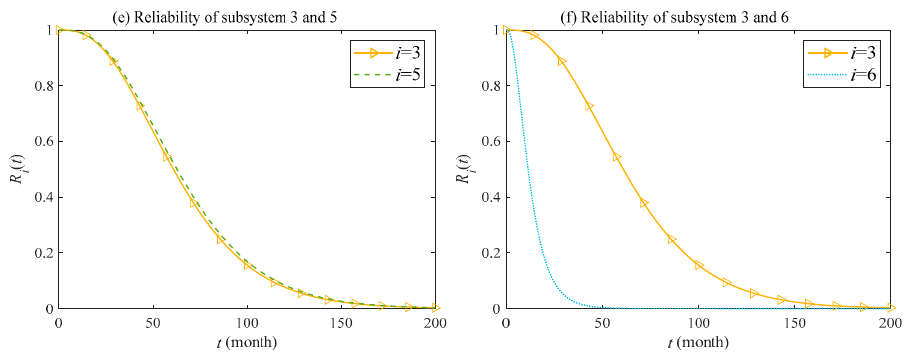
Figure 6. Comparisons of the reliability of different subsystems.